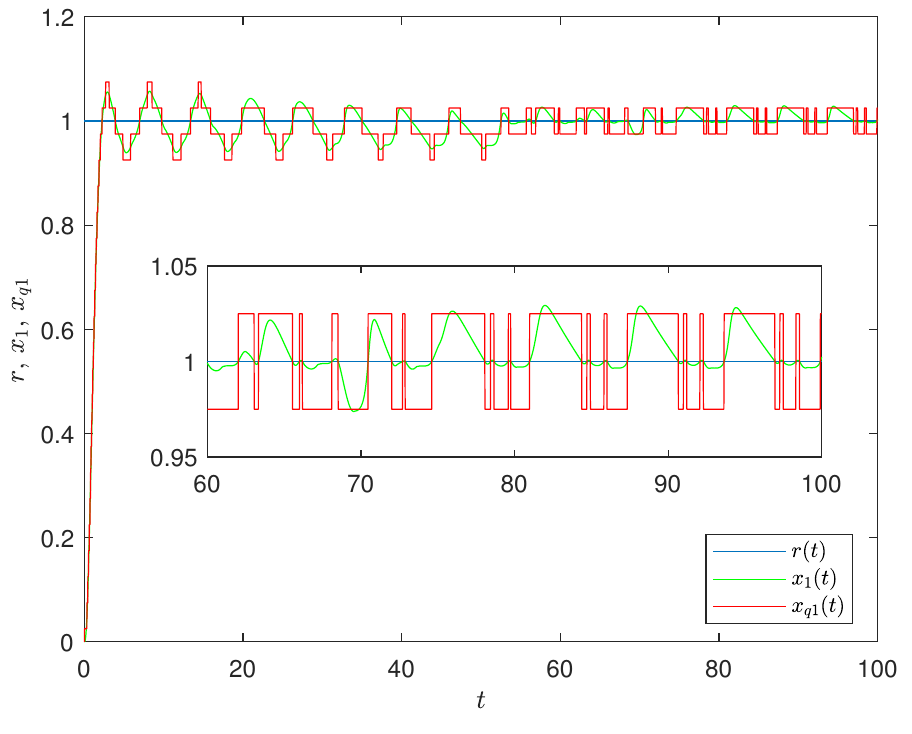
Figure 4. x 1 and x q 1 of Testings